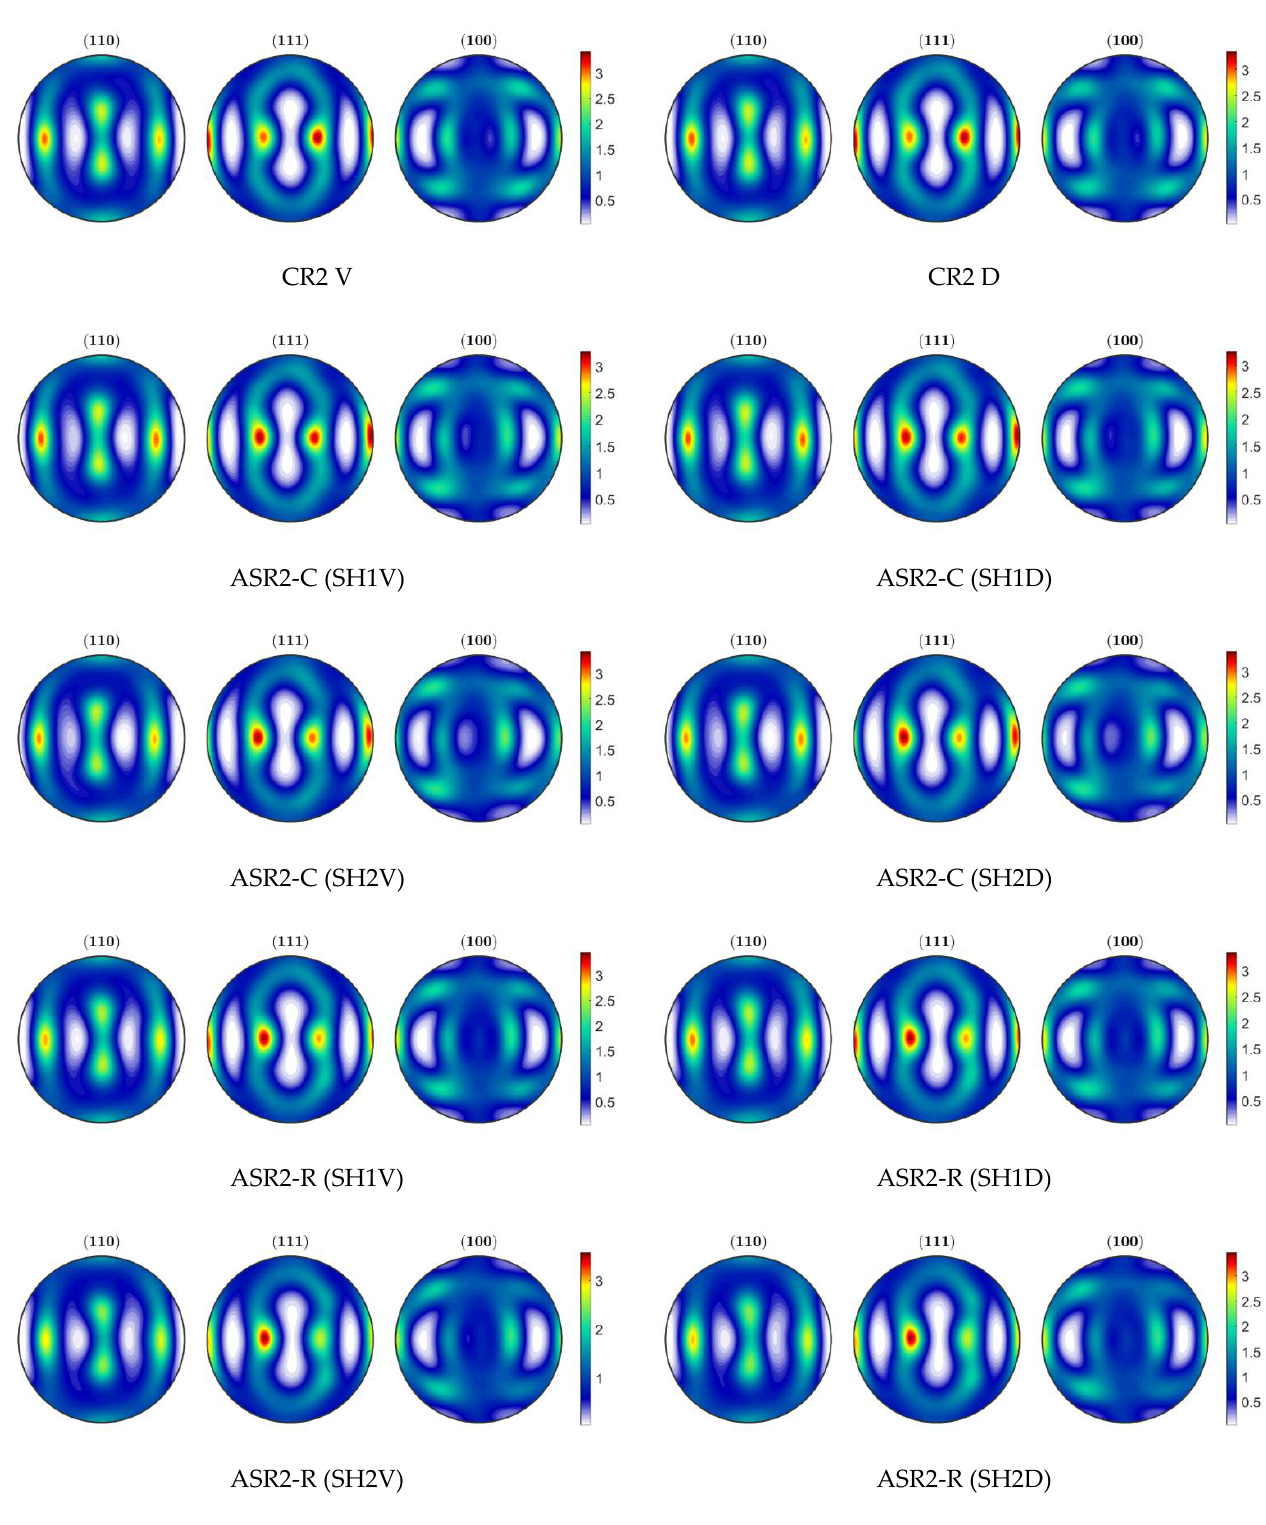
Figure A11. ODF sections for the second pass with a 30% thickness reduction per pass.